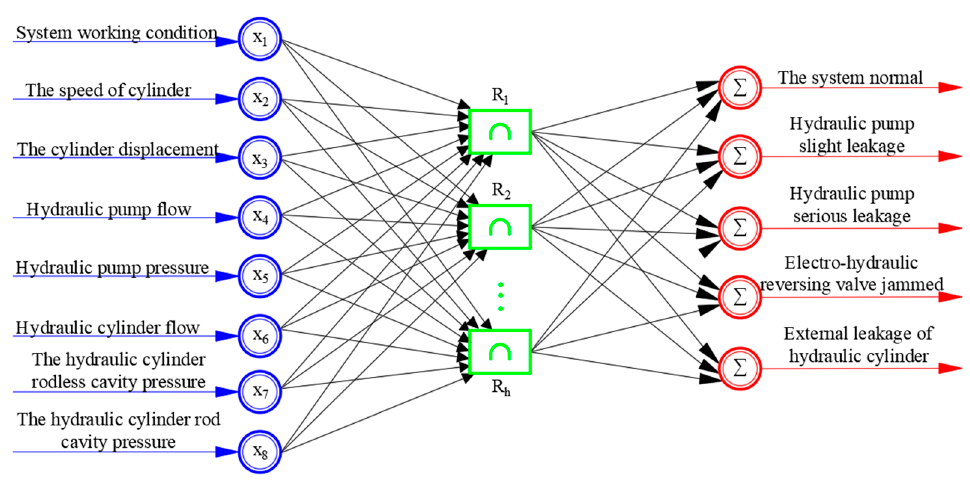
Figure 9. The topology structure of the RS-RBFNN. Table 4. The training sample.